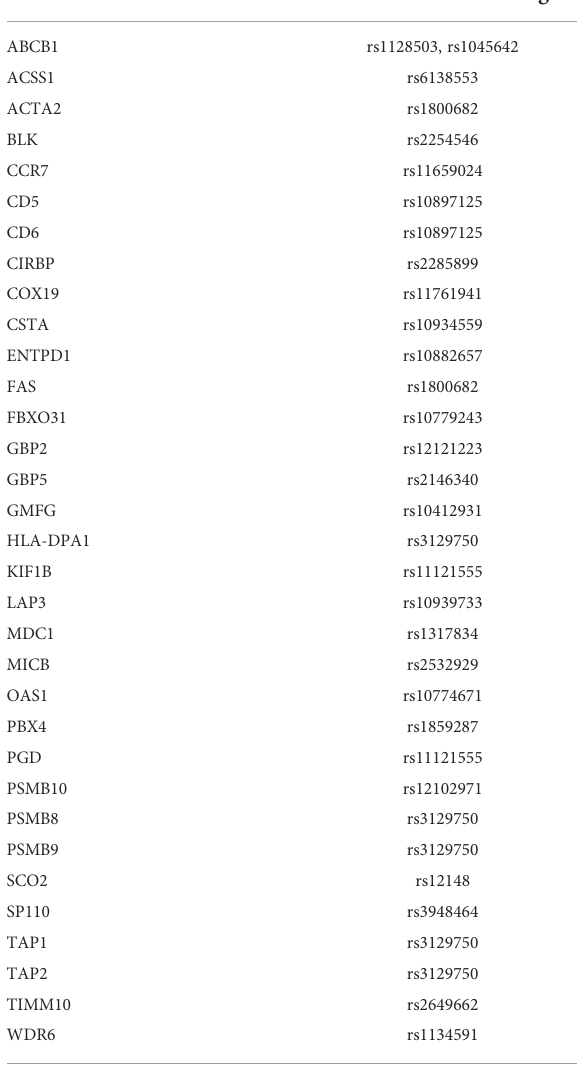
TABLE 6 List of DEGs proximal to TB-associated